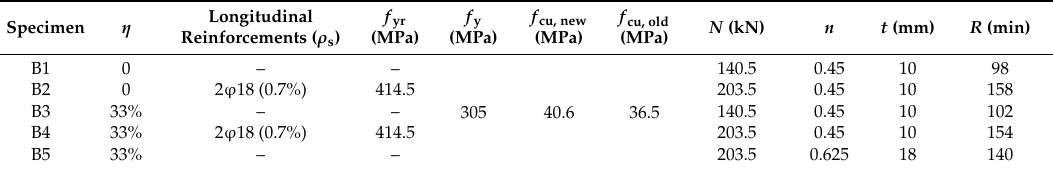
Table 1. Details of specimens.